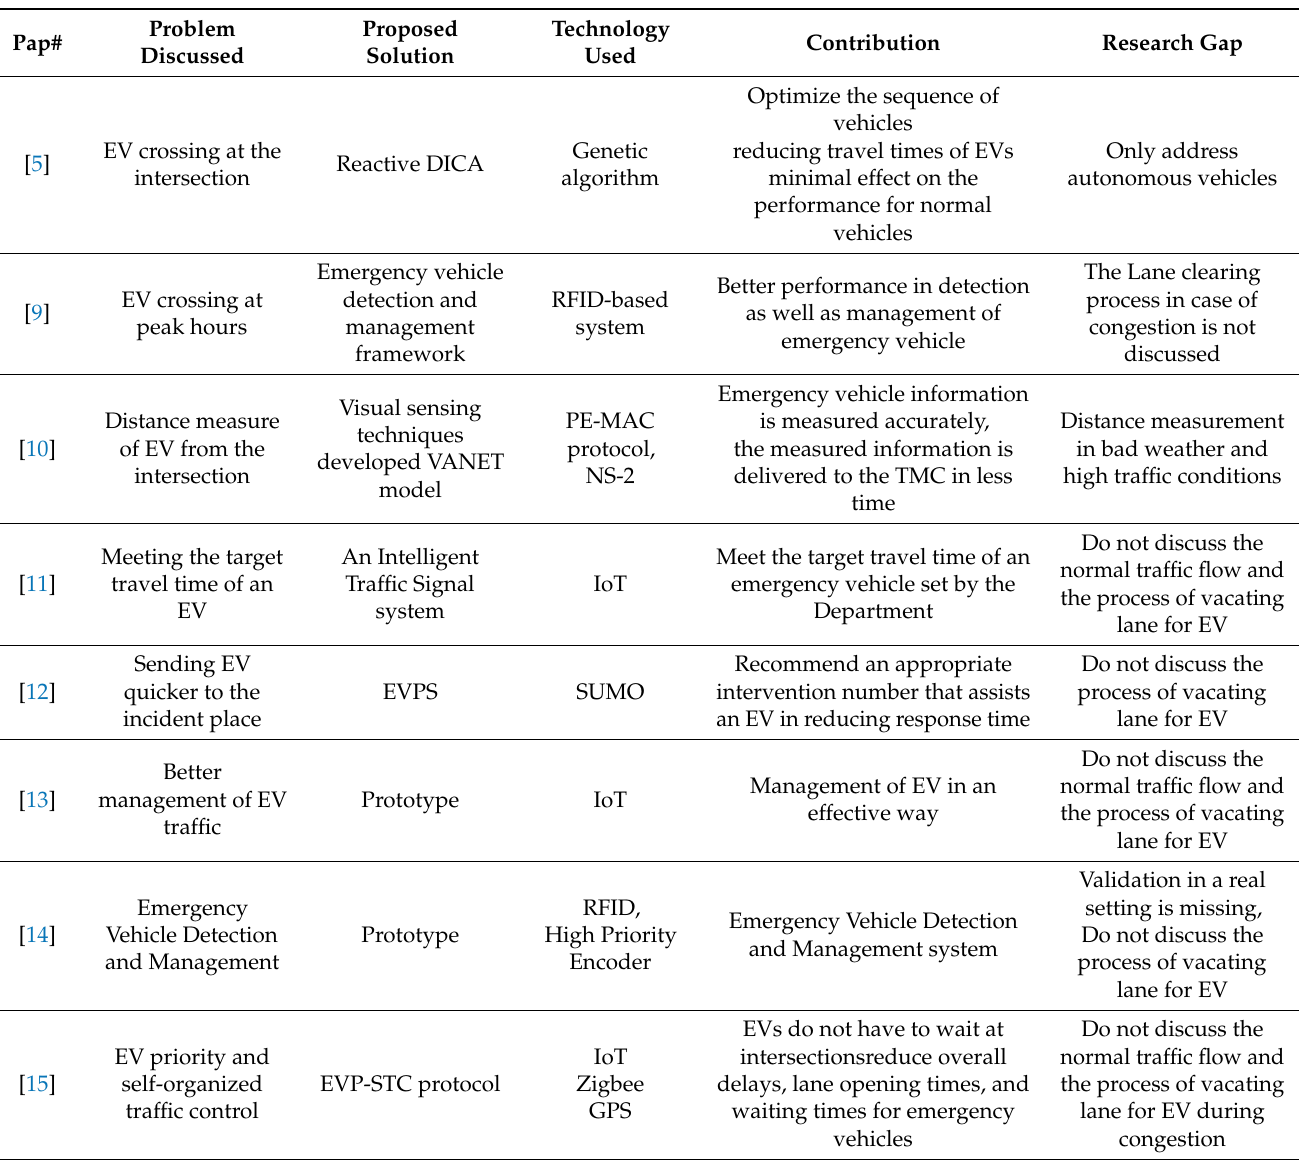
Table 2. Research Gap based on